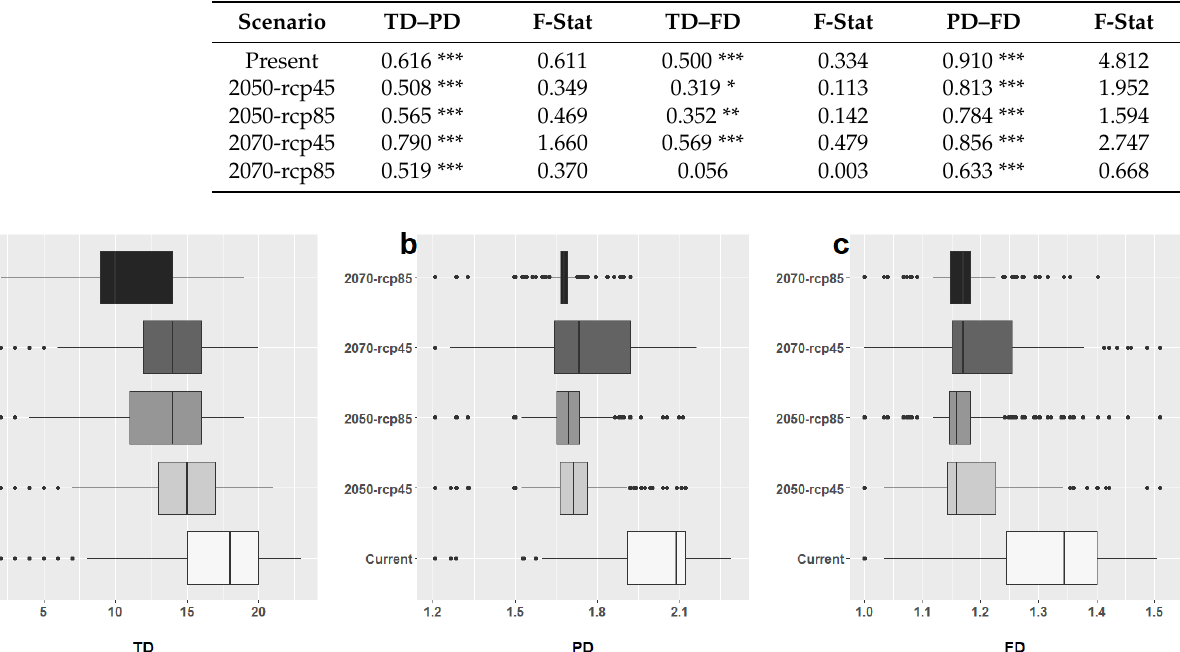
Table 1. Pearson correlations between TD, PD, and FD. Applying the Dutilleul method (1993), spatial autocorrelation was taken into account prior to the estimation of statistical significance ( p -value). In each column, the correlation value between pairs of diversities is presented. *** p < 0.001; ** p < 0.01; * p < 0.05.